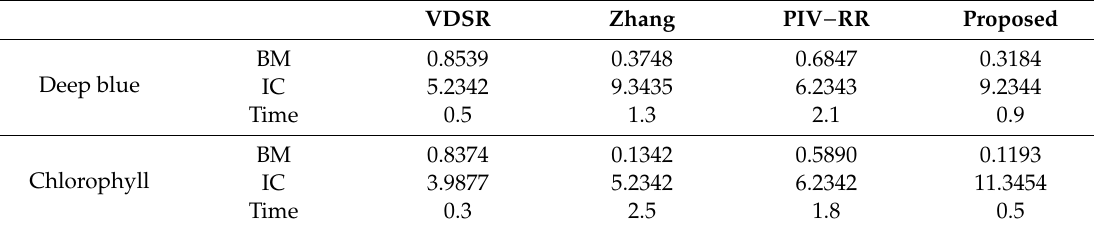
Table 10. Evaluation results and running time